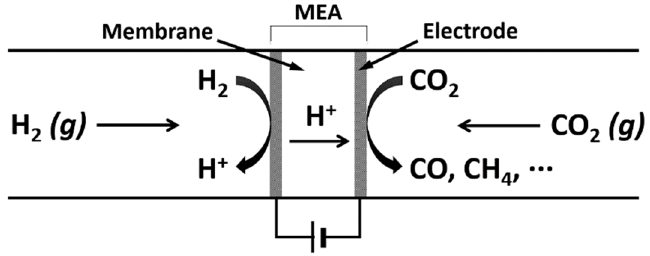
Figure 1. Schematic of a solid acid membrane cell for electrochemical reduction of gaseous CO 2 . Gaseous hydrogen and CO 2 oxidized and reduced, respectively, at each electrode. Protons move from the anode side to the cathode side through the membrane as a result of hydrogen oxidation. Cesium dihydrogen phosphate (CsH 2 PO 4 ), a representative of superprotonic solid state. Superprotonic solid acids (MH n XO 4 , M = Na, K, Cs, X = P, S, and Se) are known for